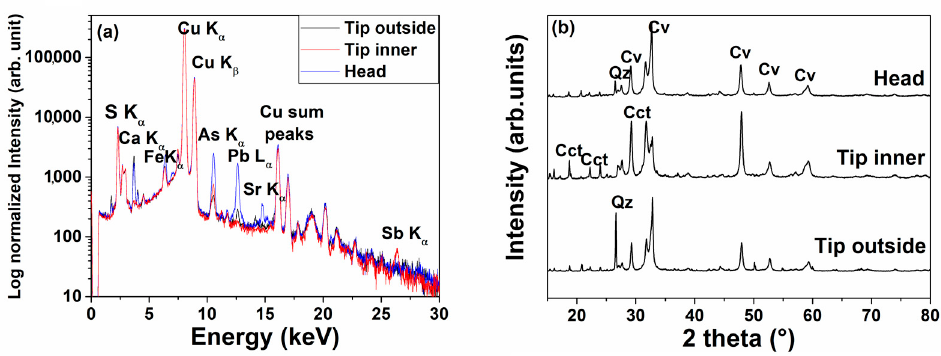
Figure 6. p XRF spectra ( a ) (the non-indexed peaks come from instrumental contribution or from elements already indexed) and XRD patterns ( b ) of the powdered nail layers (Cv = covellite, Cct = chalcanthite, Qz = quartz).